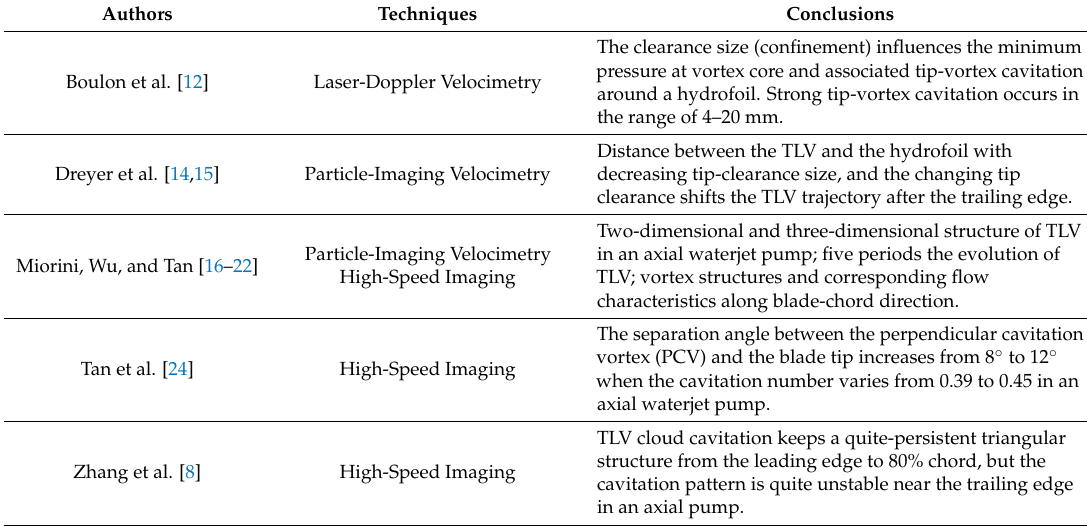
Table 2. Main experiment studies on tip-clearance